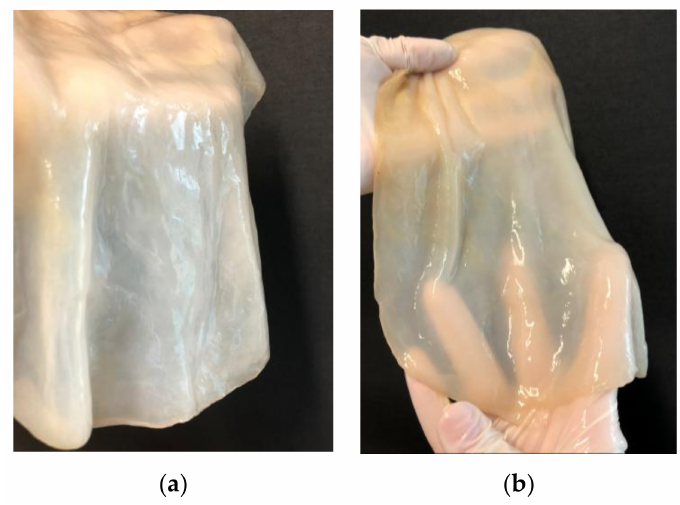
Figure 1. Microbial cellulose obtained from Gluconacetobacter xylinus strain, before removing bacterial cells ( a ), after removing bacterial cells ( b